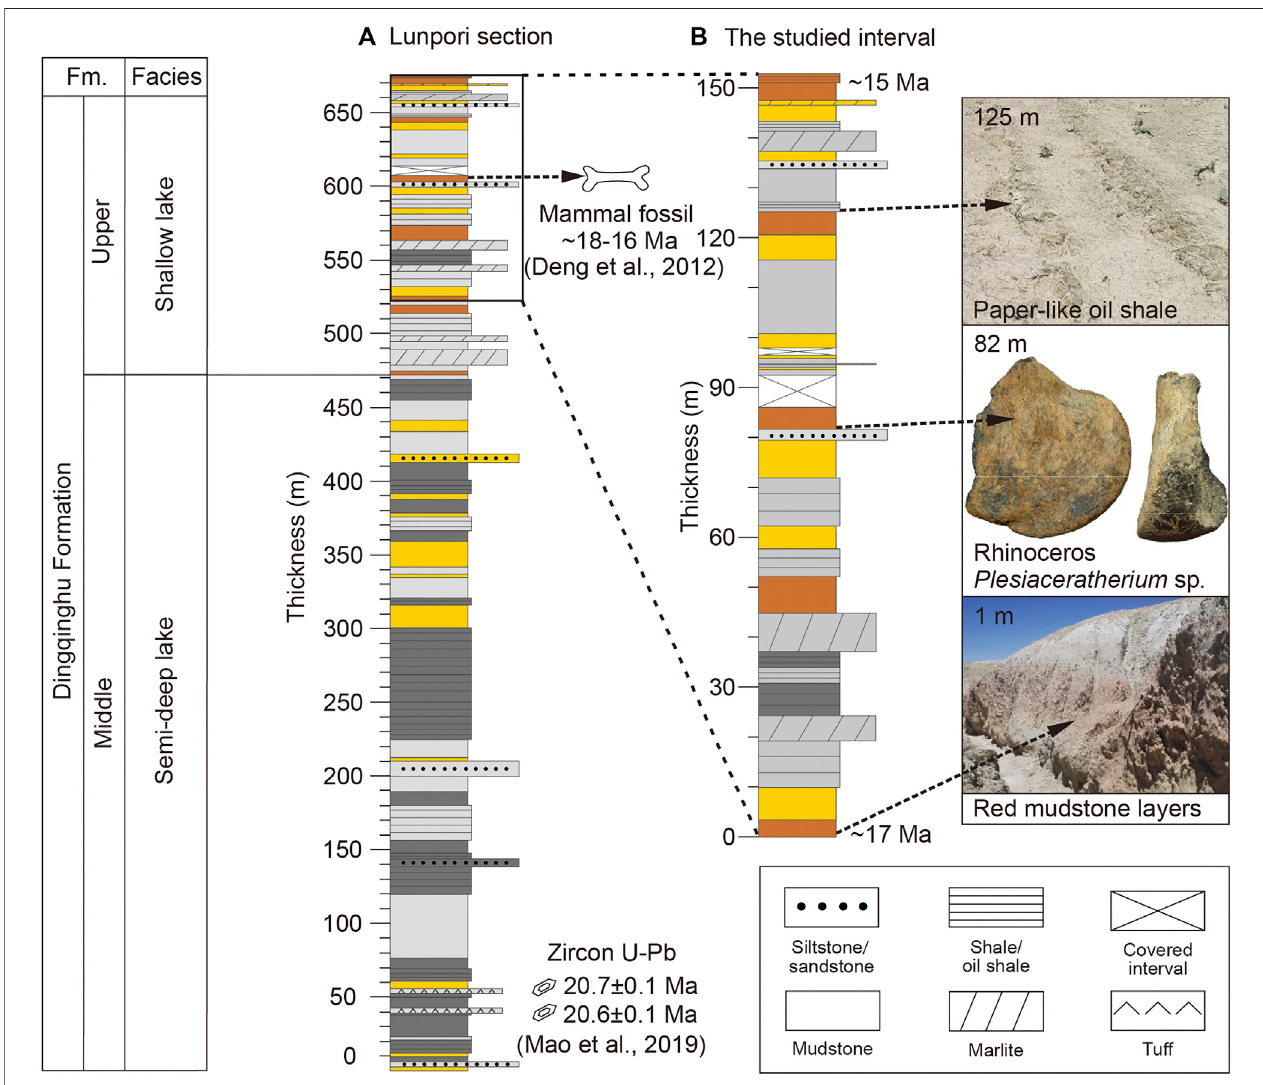
FIGURE 2 | The stratigraphy sequence and lithology of the middle-upper part of the Dingqinghu Formation in the Lunpori section. (A) The entire stratigraphic column shows two age constraints within the Lunpori section, i.e., fossil mammal ( Plesiaceratherium sp., Deng et al., 2012) and zircon dating (Mao et al., 2019). (B) Detailedstratigraphiccolumnofourstudiesinterval.Representativephotographsofthepaper-likeoilshale,fossilmammal( Plesiaceratherium sp.,Dengetal.,2012),and red mudstone layers respectively. The column colour (i.e., dark grey, light grey, yellow, and red) indicates the colour of the strata.